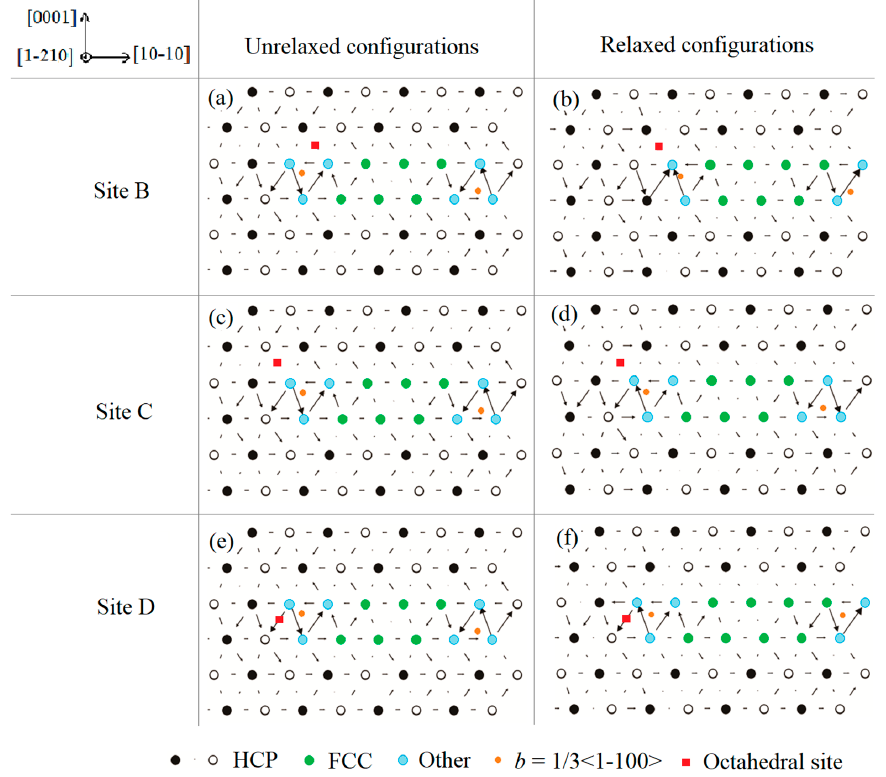
Figure 3. Core structures of dissociated < a > -type dislocation with the introduction of interstitial oxygen atom before and after relaxation. Oxygen atoms were inserted in the octahedral sites marked as red squares in the vicinity of the dislocation core. Green sites correspond to face-centered cubic (FCC) structure of stacking fault ( I 2 ). Orange dots represent the dislocation line of the partial dislocations perpendicular to the